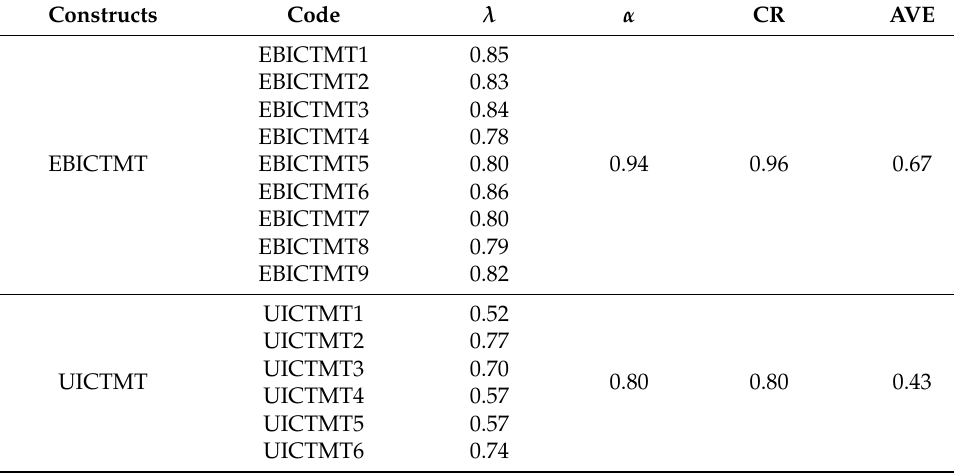
Table 1. Factor loadings, reliability, and